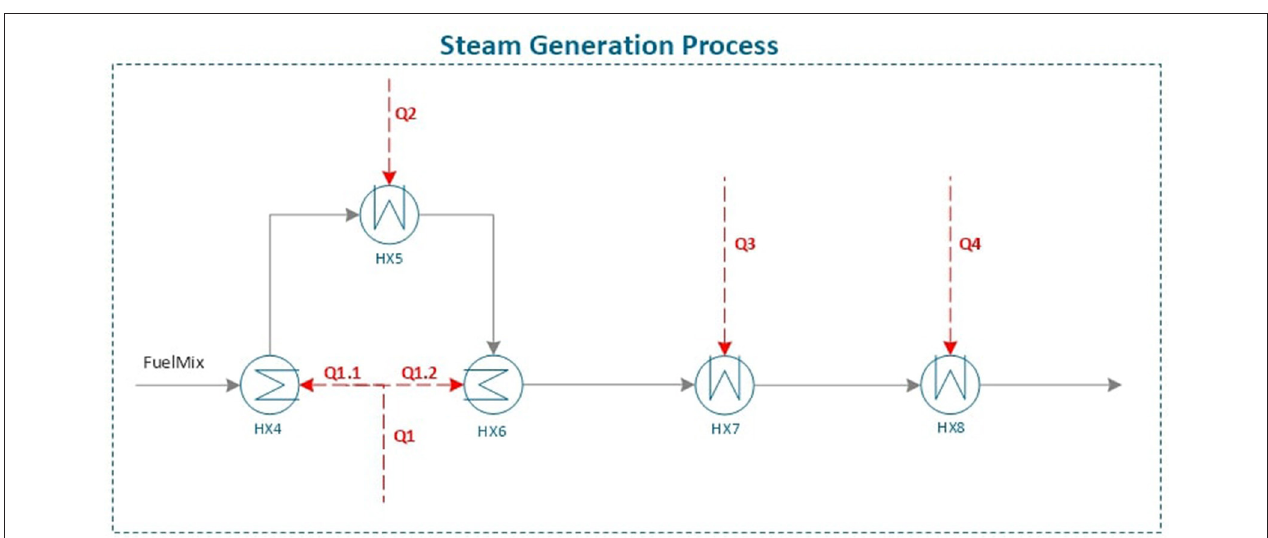
FIGURE 5 | Steam generation subsystem within the full MCEC process